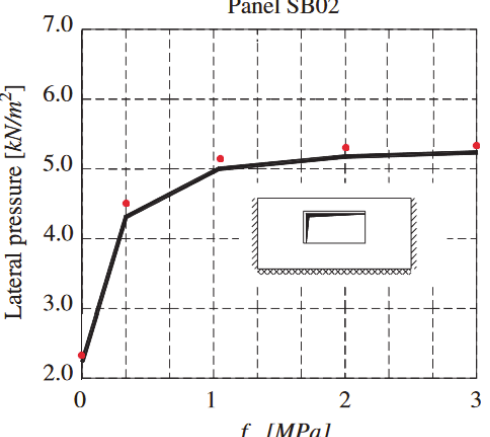
Figure 11: Dependence of the collapse load multiplier of reinforced Panel SB01 on the FRP-masonry bond strength f b . Red dots: values computed by means of the proposed GA-NURBS approach; Black line: values computed in